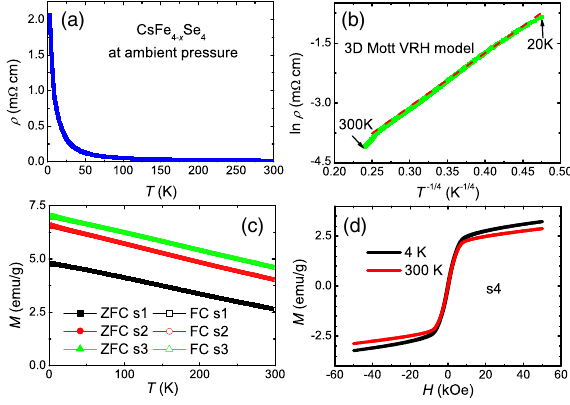
FIG. 2. Resistivity and magnetization of CsFe 4 − x Se 4 . (a) Tem- perature dependence of resistivity of CsFe 4 − x Se 4 at ambient pressure. (b) Resistivity data from 20 K to 300 K, showing a roughly linear behavior (red dashed line), which is consistent with the VRH model for the three-dimensional correlated systems. (c) Temperature dependence of magnetization measured at the field of 1 T for three samples. (d) Magnetic field dependence of magnetization measured at 4 K and 300 K for another